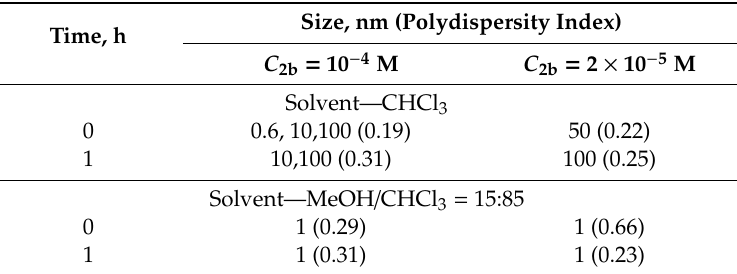
Table 2. Dependence of the number-averaged particle size distribution (PSD) of compound 2b on spreading solvent, concentration, and time after the preparation of